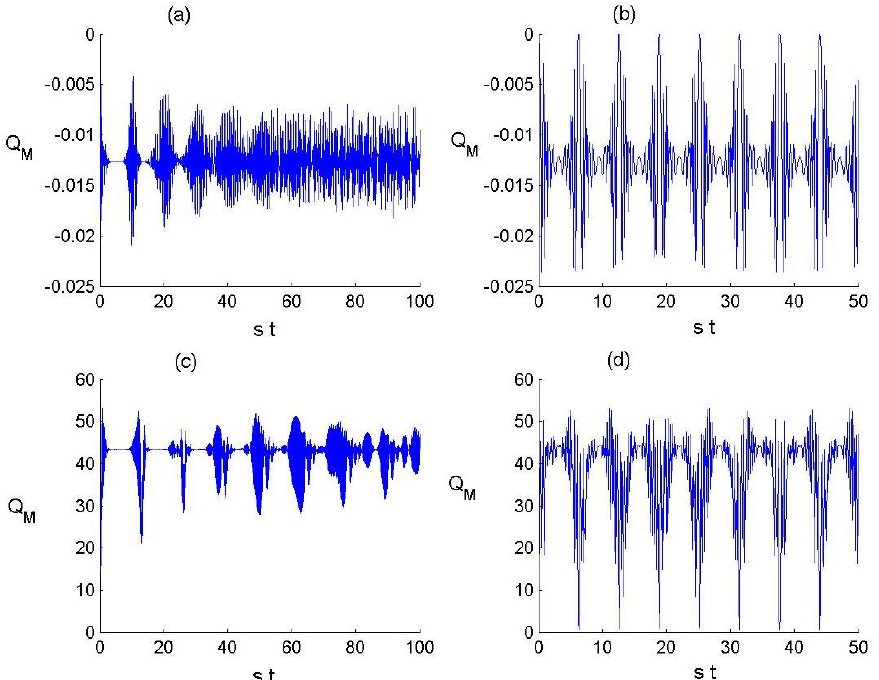
Figure 6. The time evolution of the Mandel parameter denoted by 𝑄 𝑀 . Panels ( a , b ) correspond to the case of absence of the PDP effect (i.e., 𝜆 = 0) for constant (𝐷(t) = s) and t-dc ( 𝐷(t) = s sin(t)) , respectively. Panels ( c , d ) are, respectively, the same as ( a , b ) but in the presence of the PDP effect with 𝜆 = 50 .